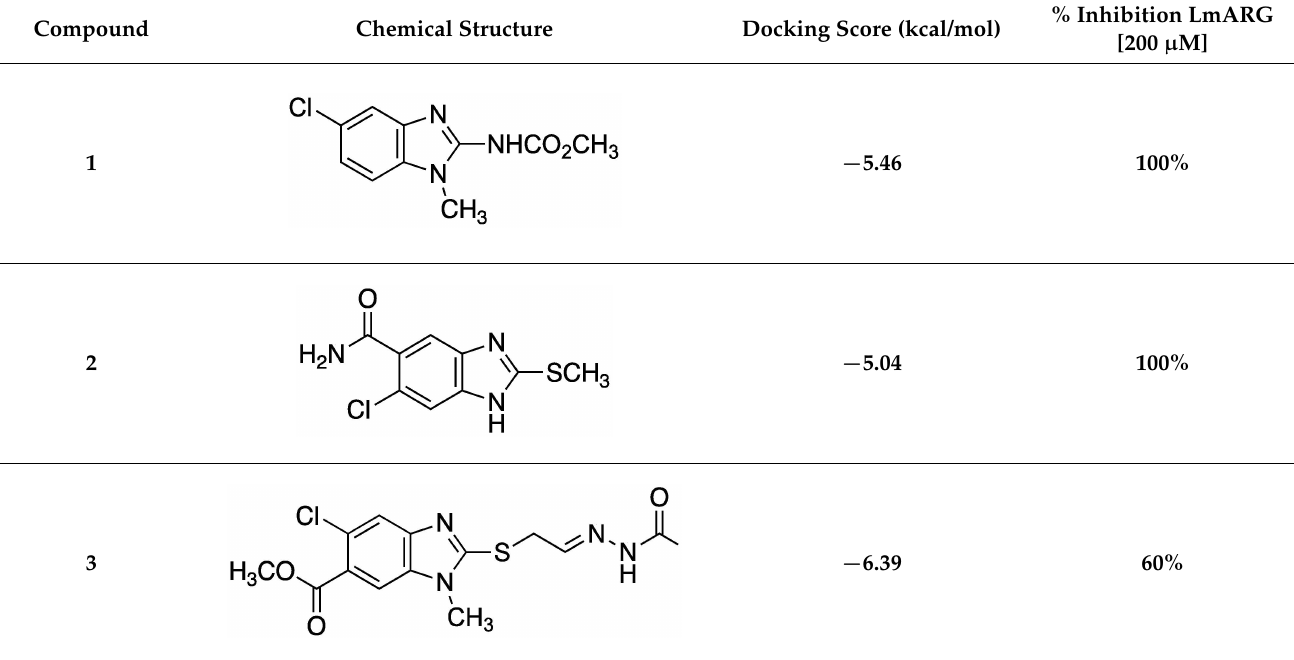
Table 1. Benzimidazole derivatives with the highest inhibition of recombinant LmARG. Compound Chemical